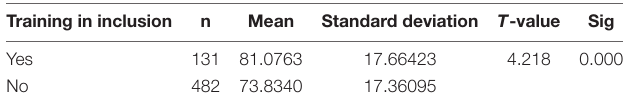
TABLE 7 | T -test: differences among the participants based on training for inclusion. Training in inclusion